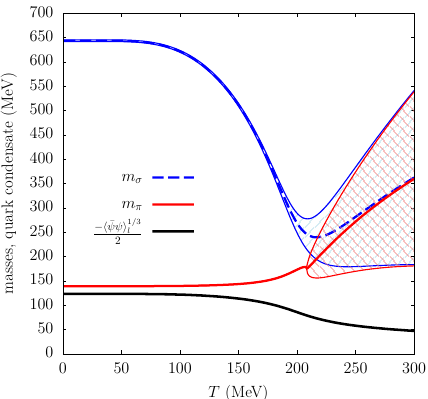
Figure 3: π (red solid line) and σ (blue dashed line) masses as functions of the temperature, below and above the chiral phase transition (signalled by the quark condensate in black line). The decay width is plotted as a band around the